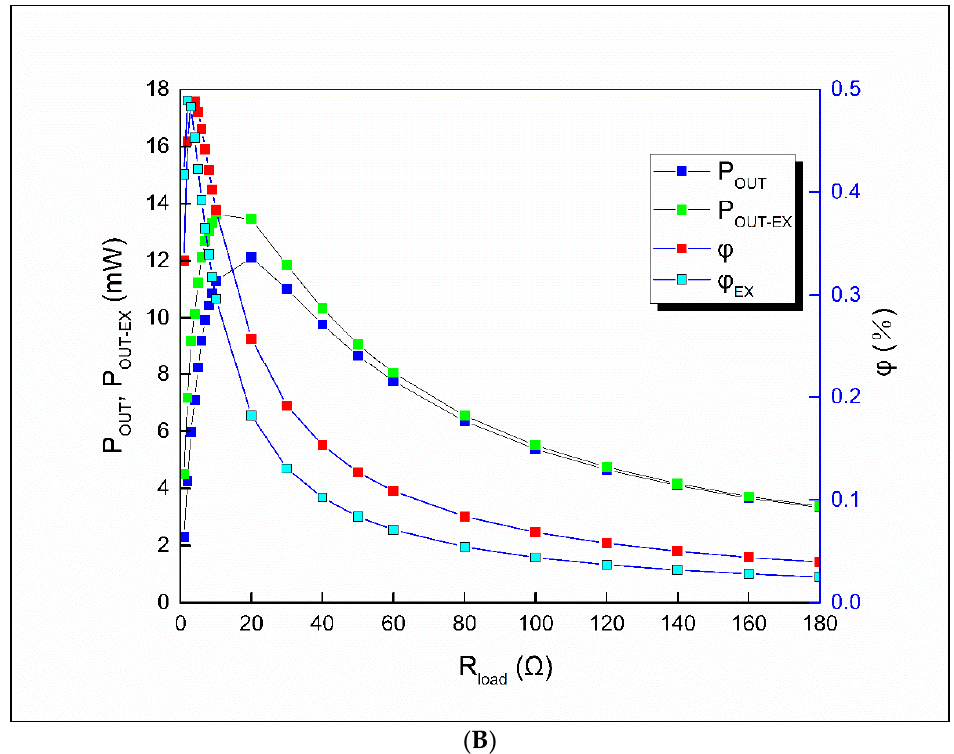
Figure 10. ( A ) Dependence of R IN / R ALL , R IN–EX / R ALL , R load / R ALL and R load–ex / R ALL on load resistance. ( B ) Dependence of P OUT , P OUT–EX , ϕ , and ϕ EX on load resistance.